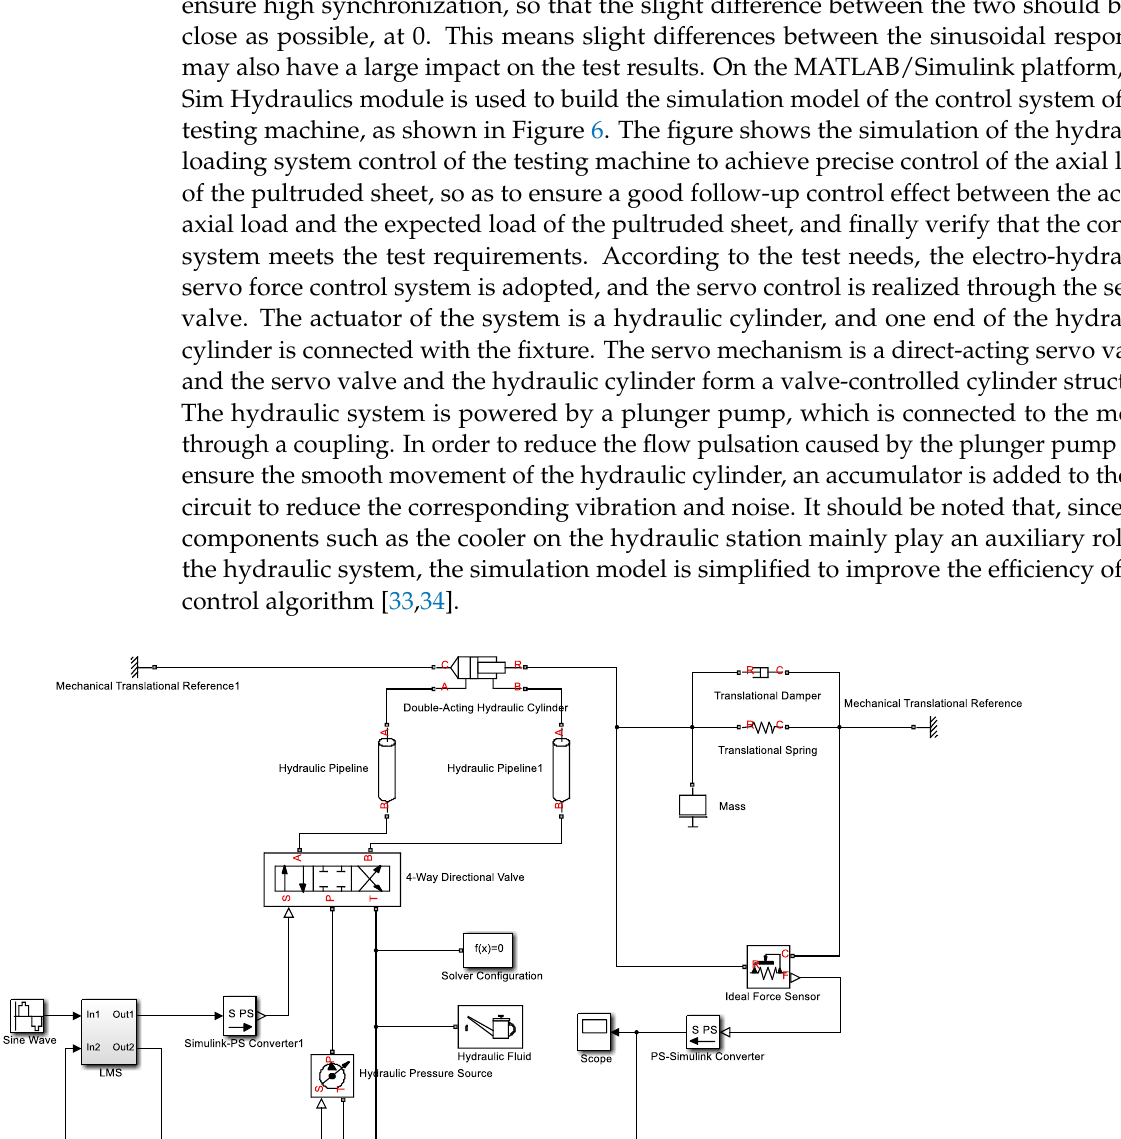
. Figure 7. Simulation curve of testing machine.